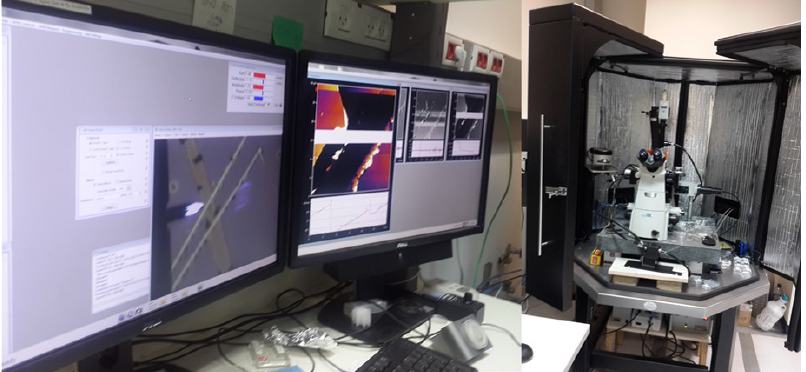
Figure 5. The laboratory in the Ilse Katz Institute for Nanoscale Science and Technology at Ben-Gurion University of the Negev, where the devices have been analyzed.